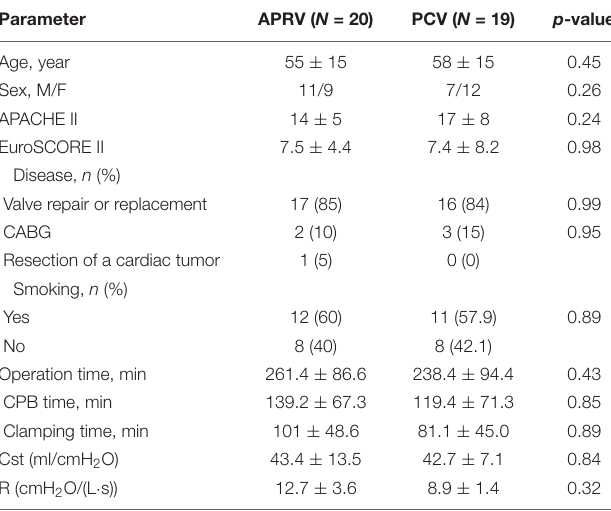
TABLE 1 | Patient demographics and baseline